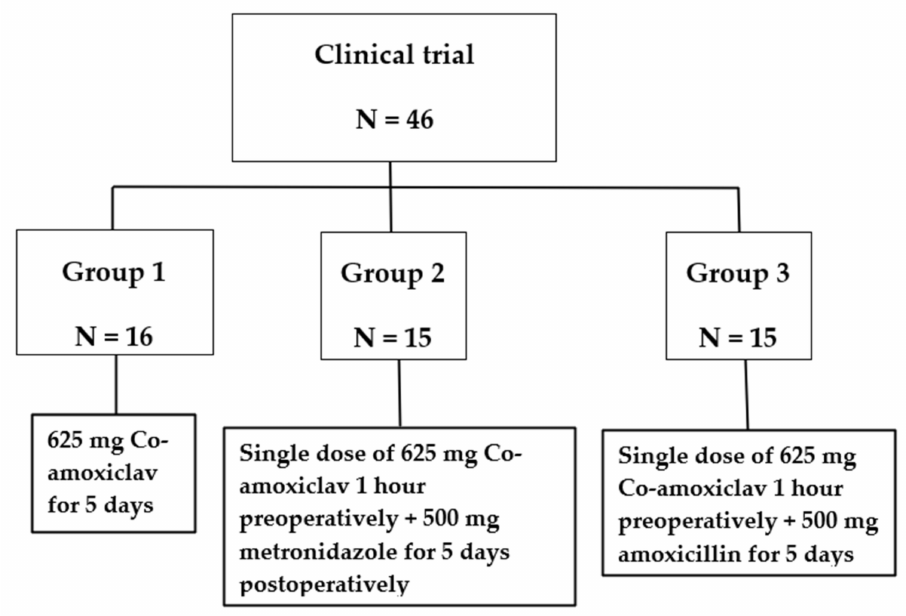
Figure 1. Description of Study design and study